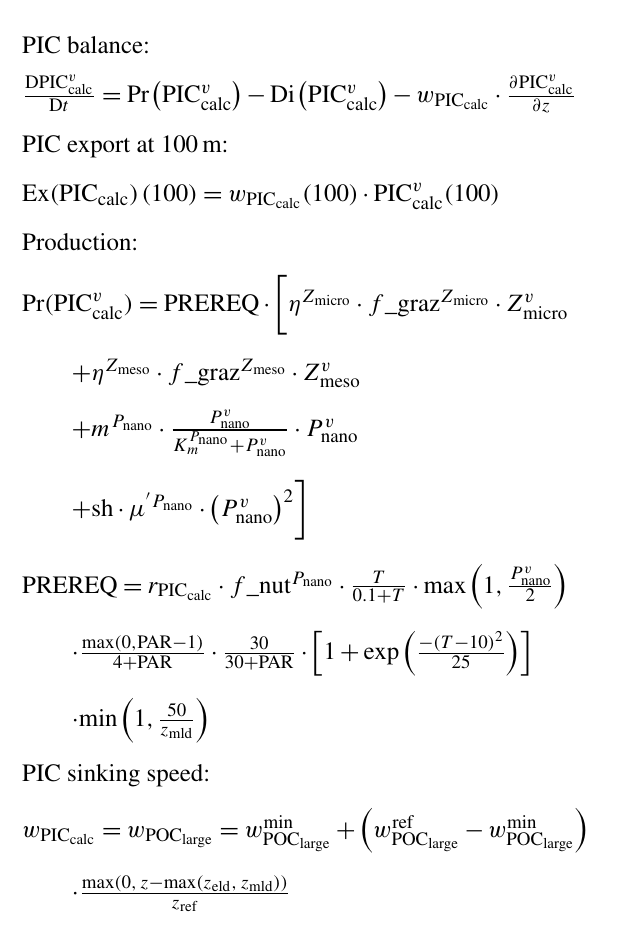
Table C6. PISCESv2 and PISCESv2-gas parameters. Variable/parameter Value Unit Description f ( miscellaneous ) Function completing the POC small / large balance f _graz Z meso f (cid:0) P nano , P diat , POC small , POC large ,T (cid:1) d − 1 Function associated with the mesozooplankton grazing rate f _graz Z micro Function associated with the microzooplankton grazing rate f _nut P nano Function regarding the nutrient limitation term for